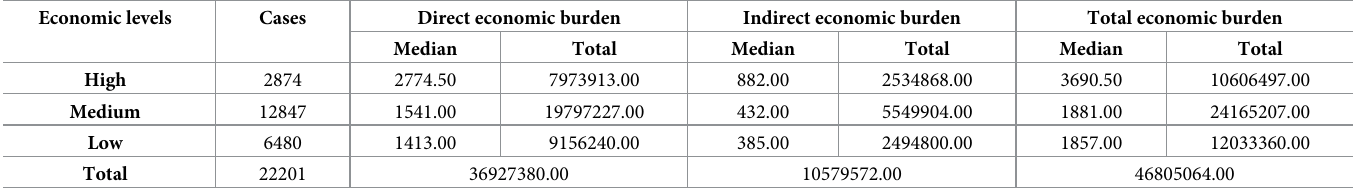
Table 3. Family economic burden of dengue fever in China in 2019 (CNY).